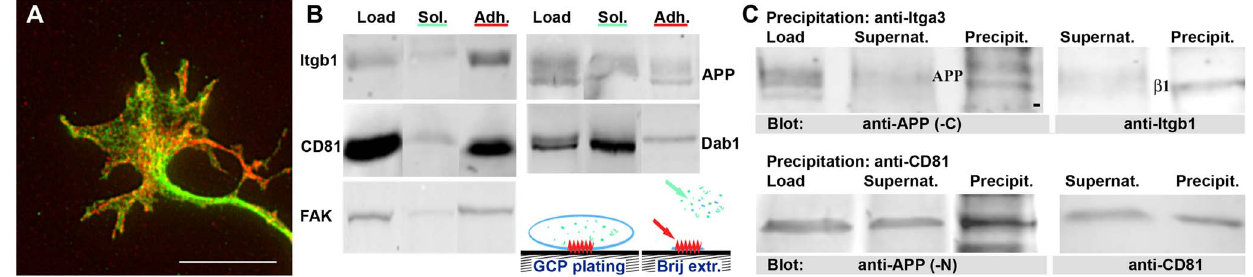
Figure 1. Presence of APP in GC adhesions. A. Immunofluorescence image of an axonal GC on laminin, fixed after 24 h in vitro and labeled with anti-APP (red) and anti-Itga3 (green). Note substantial overlap (yellow). Calibration, 10 m m. B. Isolation of GC adhesions on laminin. Rat GCPs plated on laminin were extracted with Brij98 to yield the unattached soluble fraction (see cartoon, green and blue; Sol). The remaining adherent structures (Adh, red) were recovered with SDS. The fractions were analyzed by western blot (equal fractional protein amounts loaded). Samples not extracted with Brij98 served as controls. The adhesion markers Itgb1, CD81 and FAK were enriched in the adherent fraction compared to its soluble counterpart, and significant amounts of APP and Dab1 (upper band) were detected. C. Co-immunoprecipitation of APP with Itga3 and CD81. The blots on the left show the enrichment of APP in the precipitates (N- or C-terminus-specific antibodies), while those on the right show precipitated Itgb1 ( b 1) and